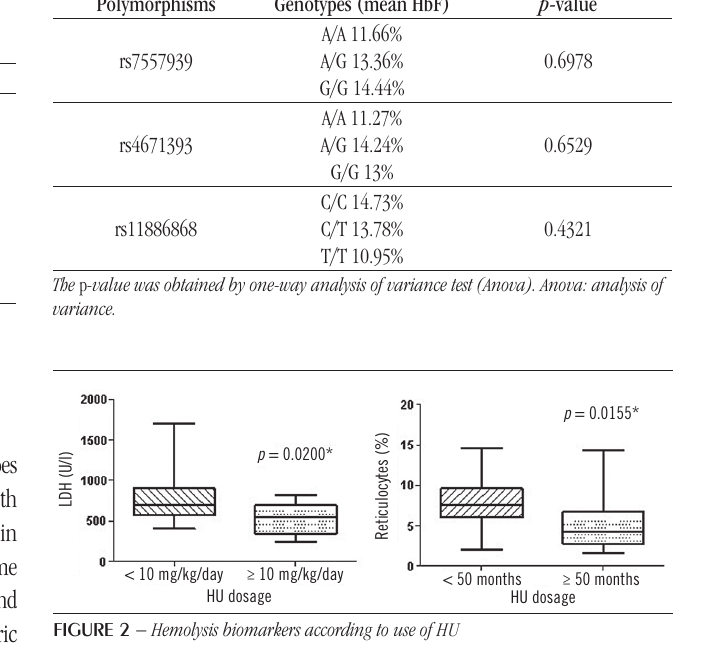
taBLE 3 − HbF concentration in the studied genotypes at the BCL11A gene